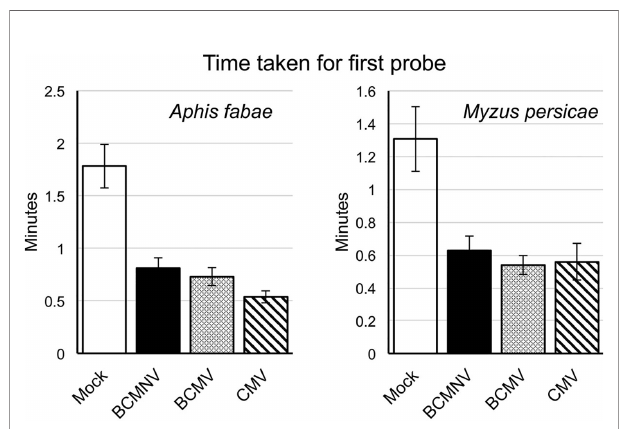
FIGURE 2 | Aphids placed on virus-infected plants initiate probing behavior sooner than on mock-inoculated common bean plants. Direct observations showed that both the legume specialist Aphis fabae and generalist Myzus persicae began probing on virus-infected plants sooner than on mock- inoculated plants. Bar charts show the mean times from placement to fi rst probe for 40 aphids per treatment group to begin probing. All experiments were done using single aphids placed on separate plants (virus-infected or mock-inoculated plants at 10 days post-inoculation/mock inoculation). Error bars represent the standard error of the mean. The decreased times-to-probe for aphids on virus-infected plants compared to mock-inoculated plants were statistically signi fi cant in all cases [survival analysis, Kaplan-Meier: p < 0.0001 ( A. fabae ) and p = 0.00012 ( M. persicae )]. Pairwise comparisons between aphid behavior on mock-inoculated and infected plants showed signi fi cant differences [Peto-Peto: BCMNV vs. Mock p = 0.00018, BCMNV vs. Mock p =